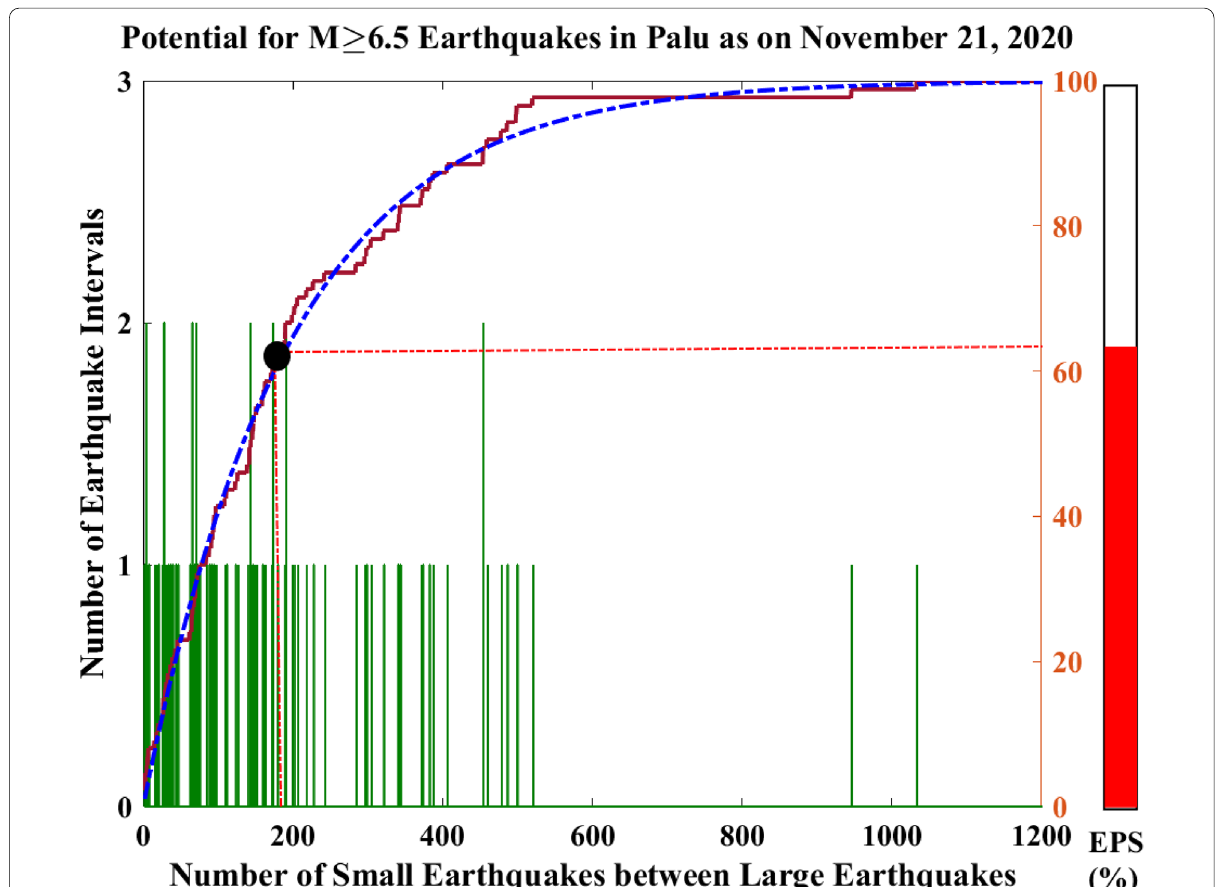
Fig. 3 Histogram of natural time counts is shown along with a demonstration of EPS computation. The dark-green bars are the histograms of the number of small earthquakes (4.5 M < 6.5) between the large earthquakes ( M 6.5). The purple step-function is the empirical distribution ≤ ≥ function derived from the histogram values. The dashed blue curve is the best-fit exponential distribution for the present natural time data. Just for demonstration, we show the black solid circle that corresponds to the number of small earthquakes as on November 21, 2020 since the last large earthquake in Palu region. The thermometer-like red bar represents the Earthquake Potential Score (EPS) showing the progression of the earthquake cycle in Palu as on November 21, 2020. However, as the seismicity in Sulawesi exhibits stationary Poisson process, the current level of seismic hazard (risk) is the same for the entire region